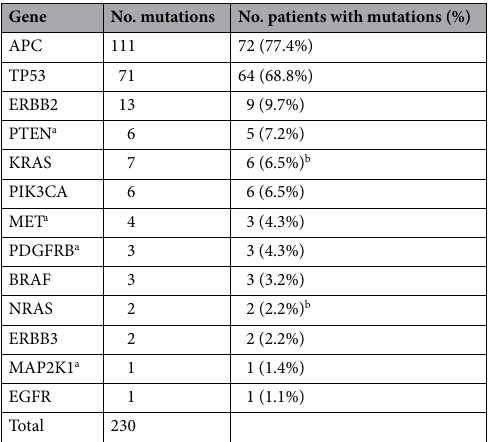
Table 2. Frequency of baseline ctDNA mutations. a Genes included only in panel version 3 used for baseline ctDNA analysis of 69 patients. b 1 patient had 2 distinct KRAS mutations and another 1 patient had both 1 KRAS and 1 NRAS